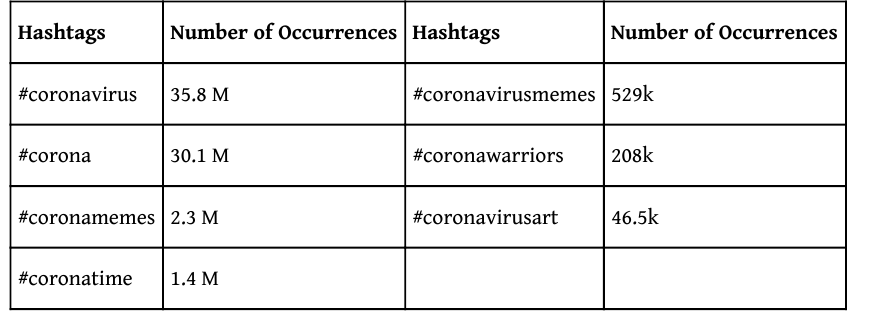
Table 7: Chosen hashtags under the basetag #corona